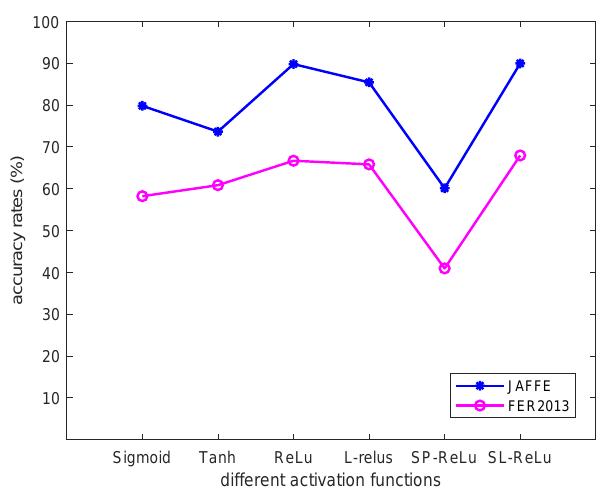
Figure 14. Experimental results based on the new created CNN model with six different activation functions.